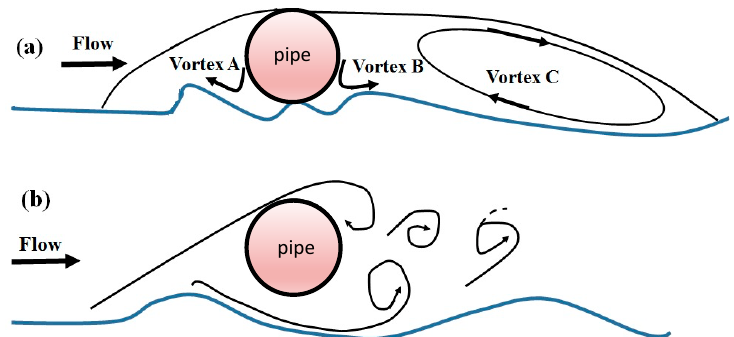
Figure 2. Schematic diagram of onset scouring process for submarine pipelines under currents. ( a ) Vortex A in front of the pipe, Vortex B in the corner downstream of the pipe, and the largest Vortex C behind the pipe; ( b ) vortex shedding that forms after the scour develops.